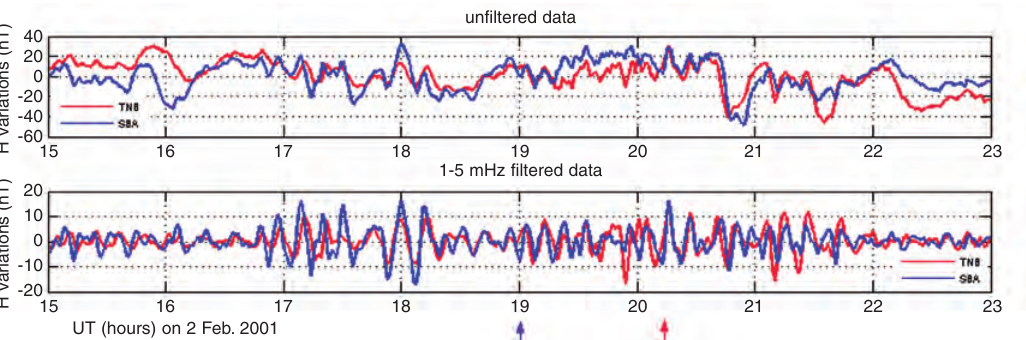
Fig. 7. Variation of the H component (unfiltered data, upper plot; 1-5 mHz filtered data, lower plot) at TNB (red line) and SBA (blue line). The red and blue arrows indicate the local geomagnetic noon at the two stations,